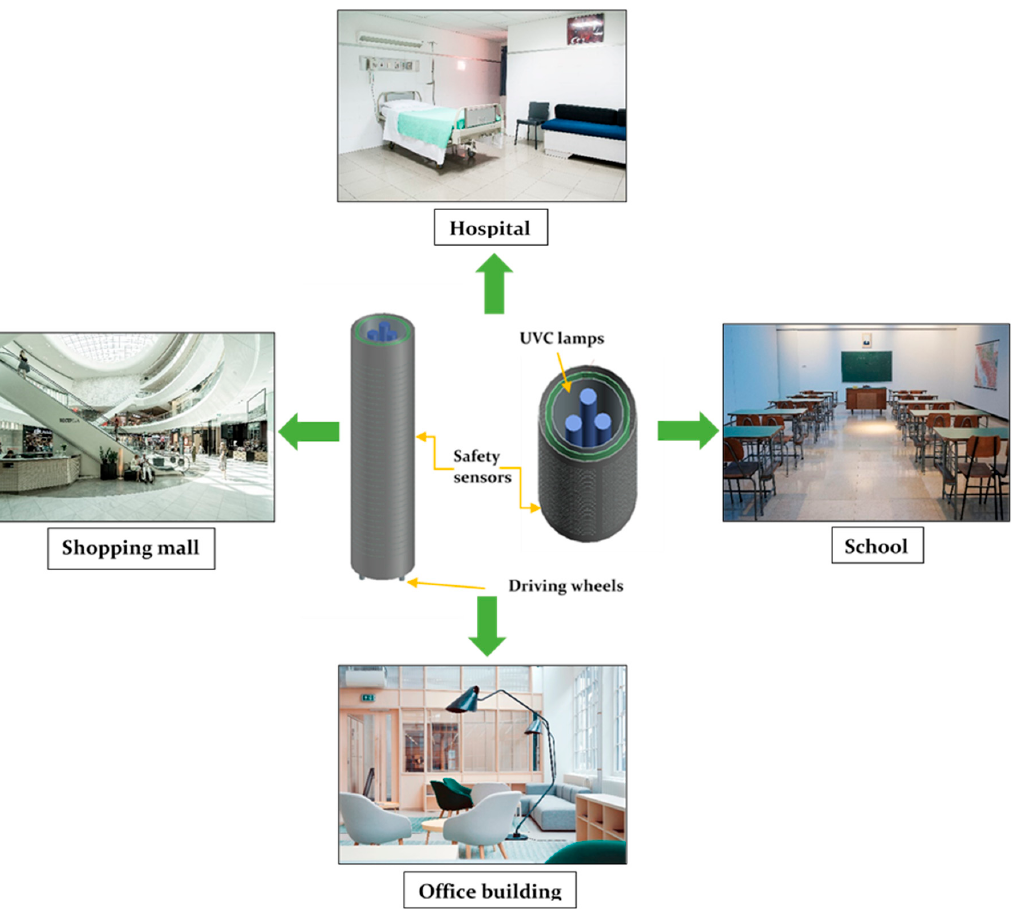
Figure 10. Mobile UVGI device and its application in different places (photos: reproduced with permission under the terms of the Creative Commons CC0 license. 2021, published on Pexels website).